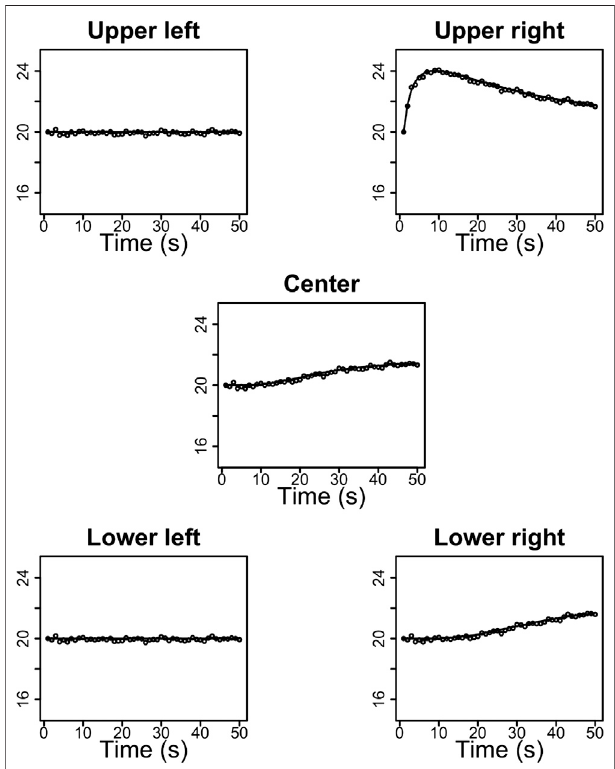
FIGURE 3 | Observations at the observation locations and true curve.